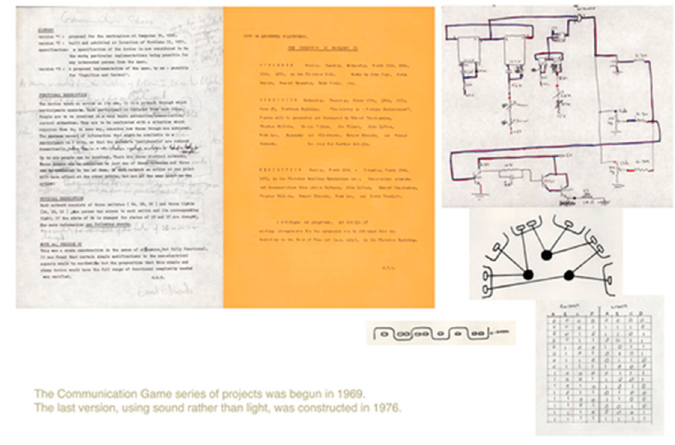
Figure 5. “The Communication Game” (1969) by Ernest Edmonds. Used by permission of Ernest